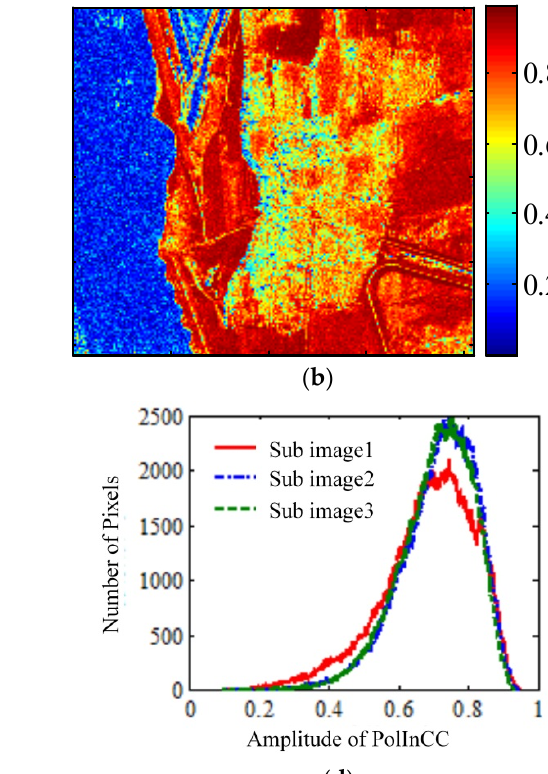
11 of 20 ured via random sampling (45 samples), in the forest was 19.29 m. Figure 6a depicts an optical map of this area from Google Earth, and Figure 6b presents a Pauli base polariza- tion decomposition map of the full-polarization SAR data. The data size was 8192 × 4096 pixels. ( a ) ( b ) Figure 6. Airborne PolInSAR experimental data. ( a ) Google Earth optical map of forest area. ( b ) Pauli base PolSAR decomposition map. Figure7a – c depict amplitude maps of PolInCCs for different sub-views of the HV polarization channel after FS processing. The number of sub-views is consistent with the number of sub-views shown in Figure 2 and the corresponding viewing angles. It can be seen that the PolInCCs of the forest area under different sub-views exhibited obvious changes. The amplitude of the PolInCCs of sub view 1 was slightly lower than those of the other sub-views. One possibility is that the polarization scattering characteristics of the ground objects from the perspective of the two interferometric channels were greatly different when the viewing angle was larger, thus resulting in a decrease in the coher- ence of the two channels. Figure 7d depicts a statistical curve of the PolInCCs’ ampli- tudes in different sub-views of the HV polarization channel in the above-described for- est area. It can be seen that the coherence coefficient of sub-view 1 was significantly lower than those of the other two sub−views, and the coherence coefficients of sub-view 2 and sub-view 3 were close to each other, but overall the coherence coefficient of sub-view 2 was slightly higher. This indicates that the scattering information for the